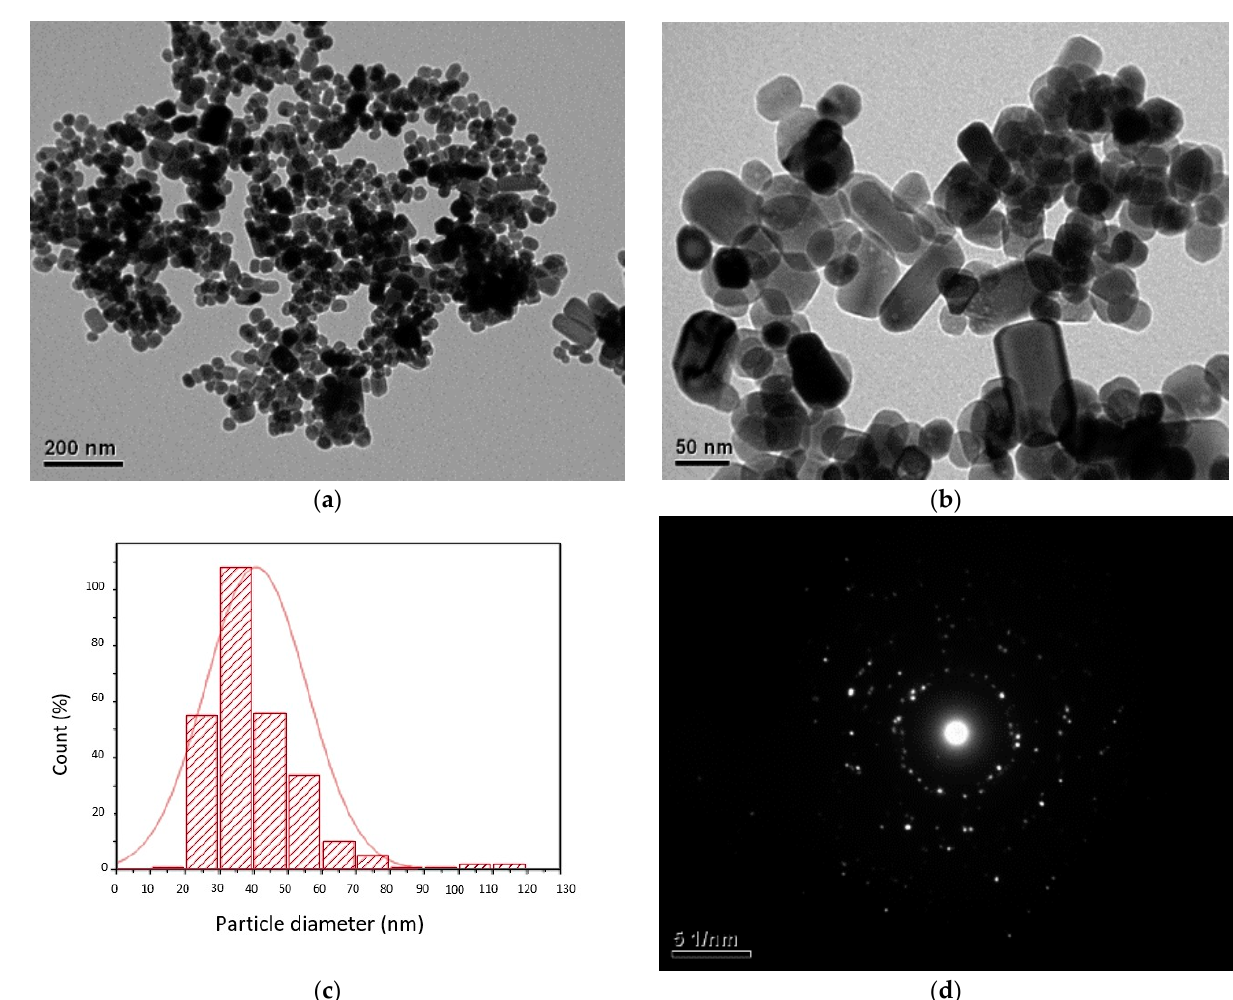
Figure 1. ( a ) and ( b ) TEM micrograph of ZnO-NPs; ( c ) particle size distribution of ZnO-NPs; and ( d ) EDS patterns of ZnO- NPs.